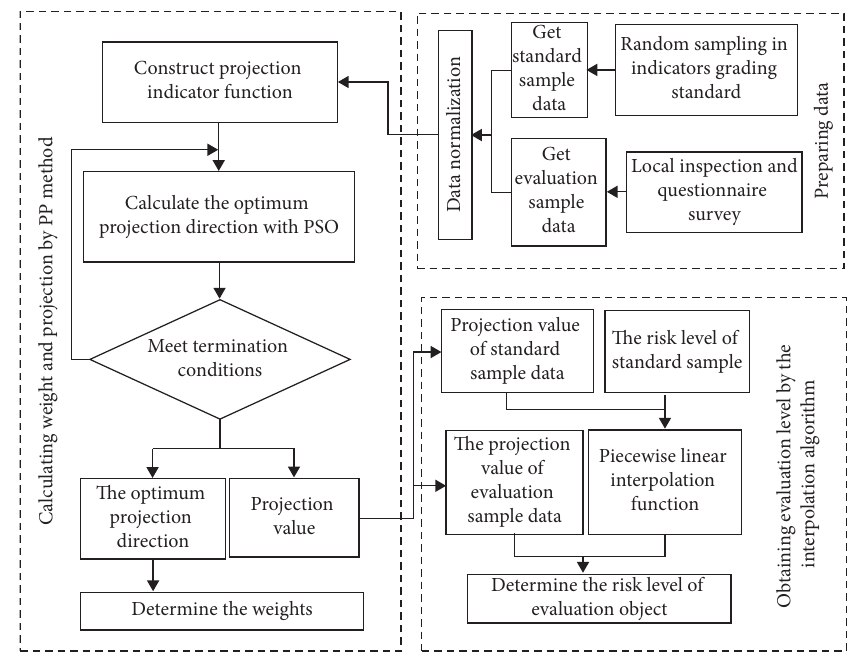
Figure 1: Flow chart of the waterlogging risk evaluation method based on the